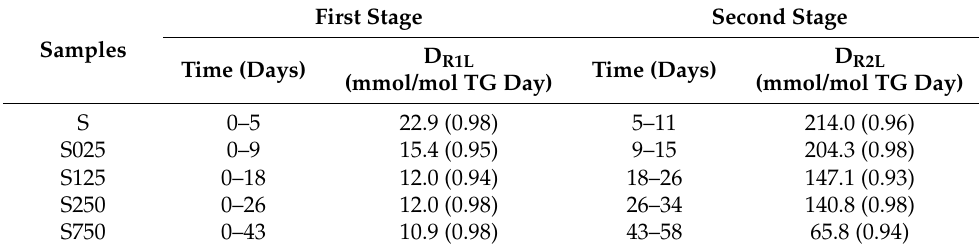
given in ples S, S 025 , S 125 , S 250 and S 750 submitted to accelerated storage at 70 °C up to a very advanced oxida-